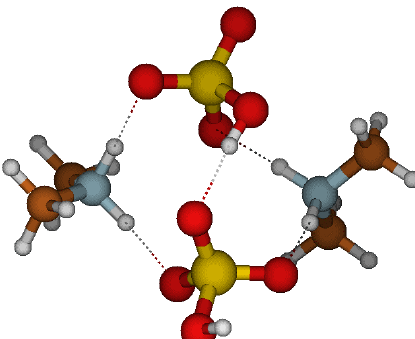
Fig. 1b. Most stable (H 2 OS 4 ) 4 (NH 3 ) 3 cluster structure, Yellow, red, white, and blue spheres represent sulfur, oxygen, hydrogen and nitrogen atoms,